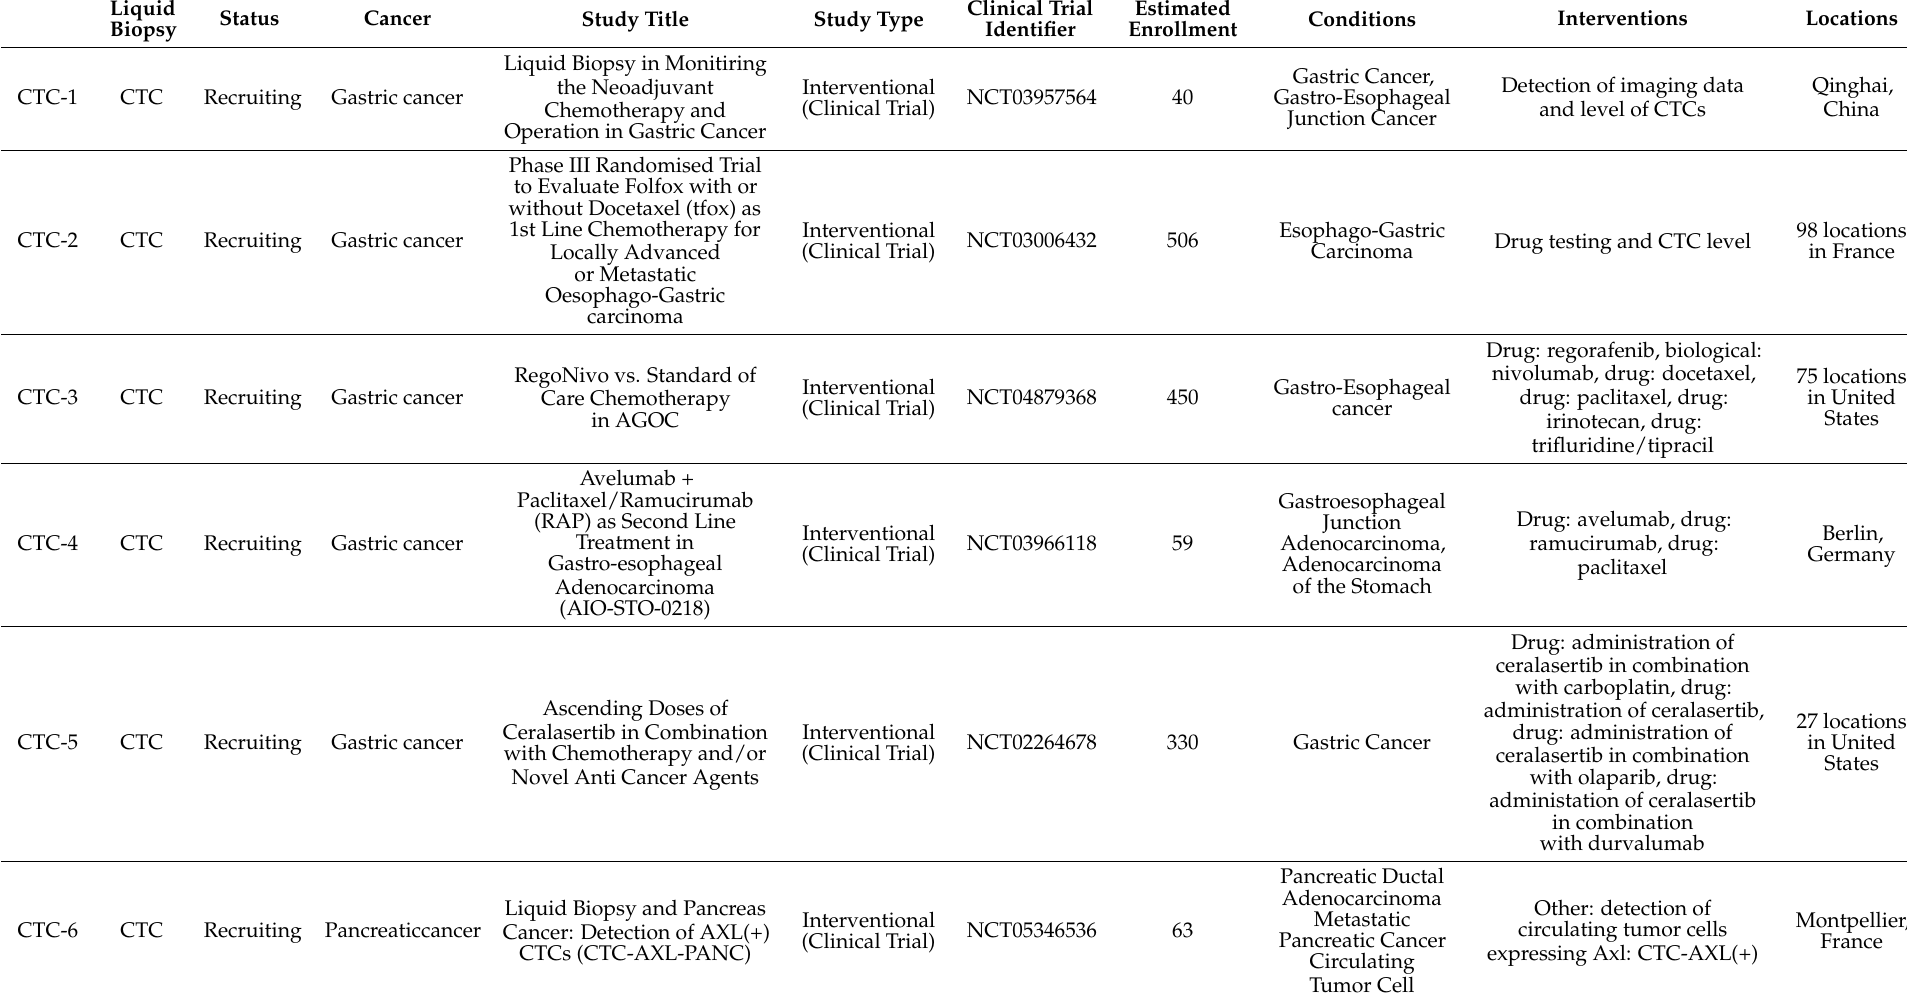
Table 6. Interventional study with ongoing clinical trials of LBs in